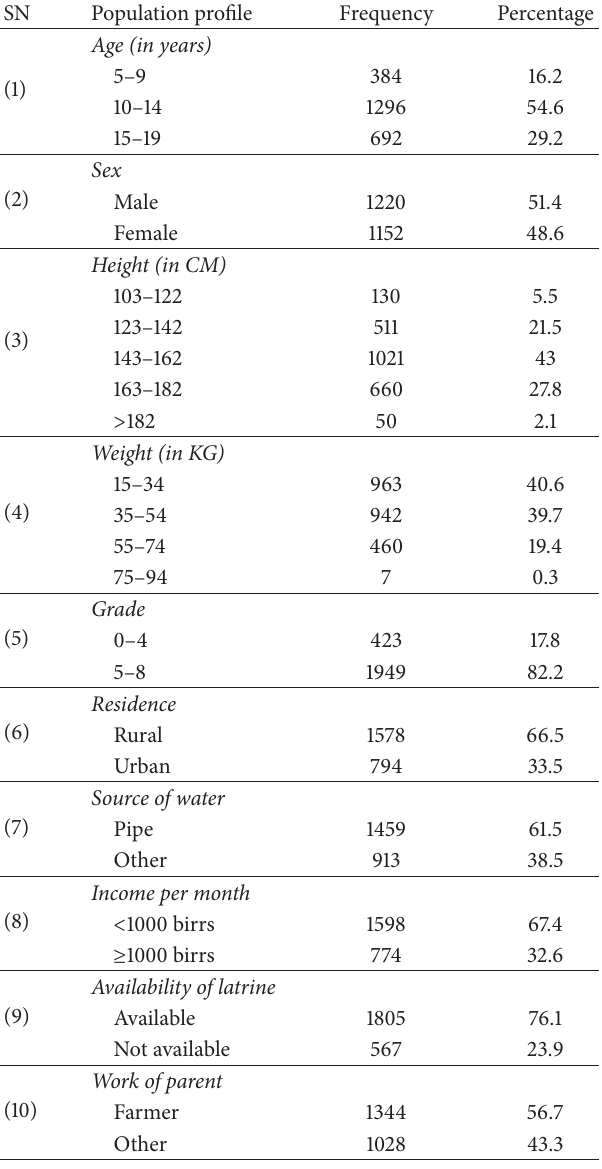
Table 1: Population profile of the study participants ( 𝑛 = 2372